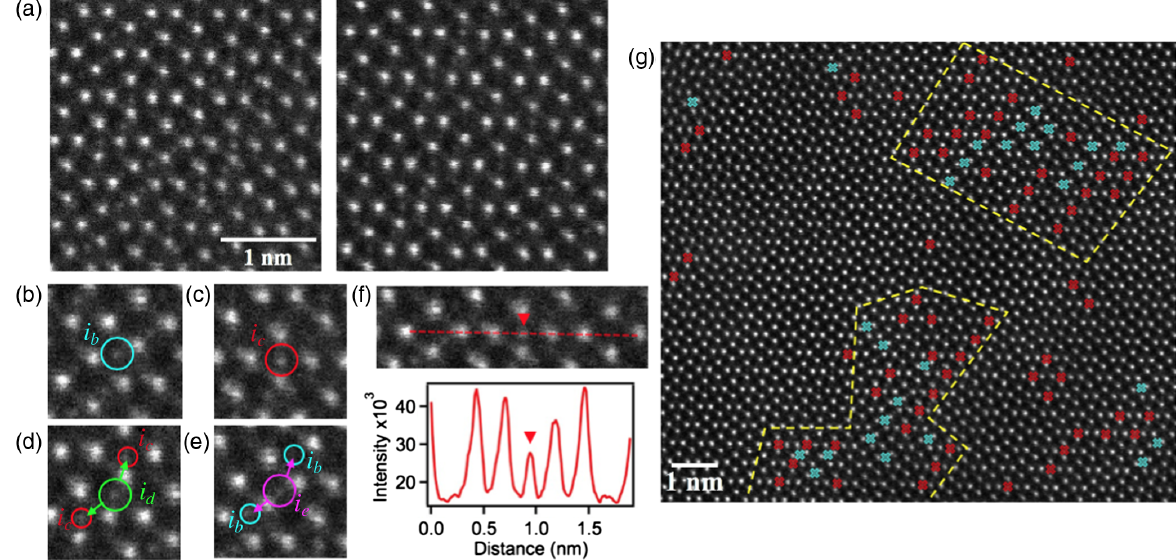
FIG. 2. Direct detection of interstitial defects in Sn-doped β -Ga 2 O 3 . (a) HAADF-STEM images from two regions (left and right) with clustered interstitial defects. Magnified locations from the image (a-left) with intensity located in interstitial sites (b) i b , (c) i c , (d) i d , and (e) i e are marked corresponding to Fig. 1(a). Arrows in (d) and (e) point towards accompanying interstitials in the i b and i c sites. (f) Intensity is evaluated across the red-dashed line, demonstrating the significant signal scattered from the cation interstitial atoms located in the i c site (red triangle). (g) Positions of i b (aqua mark) and i c (red mark) interstitial atoms identified in a larger area of β -Ga 2 O 3 . Yellow-dashed outlined areas indicate the interstitials clustering and concentrating in areas of about